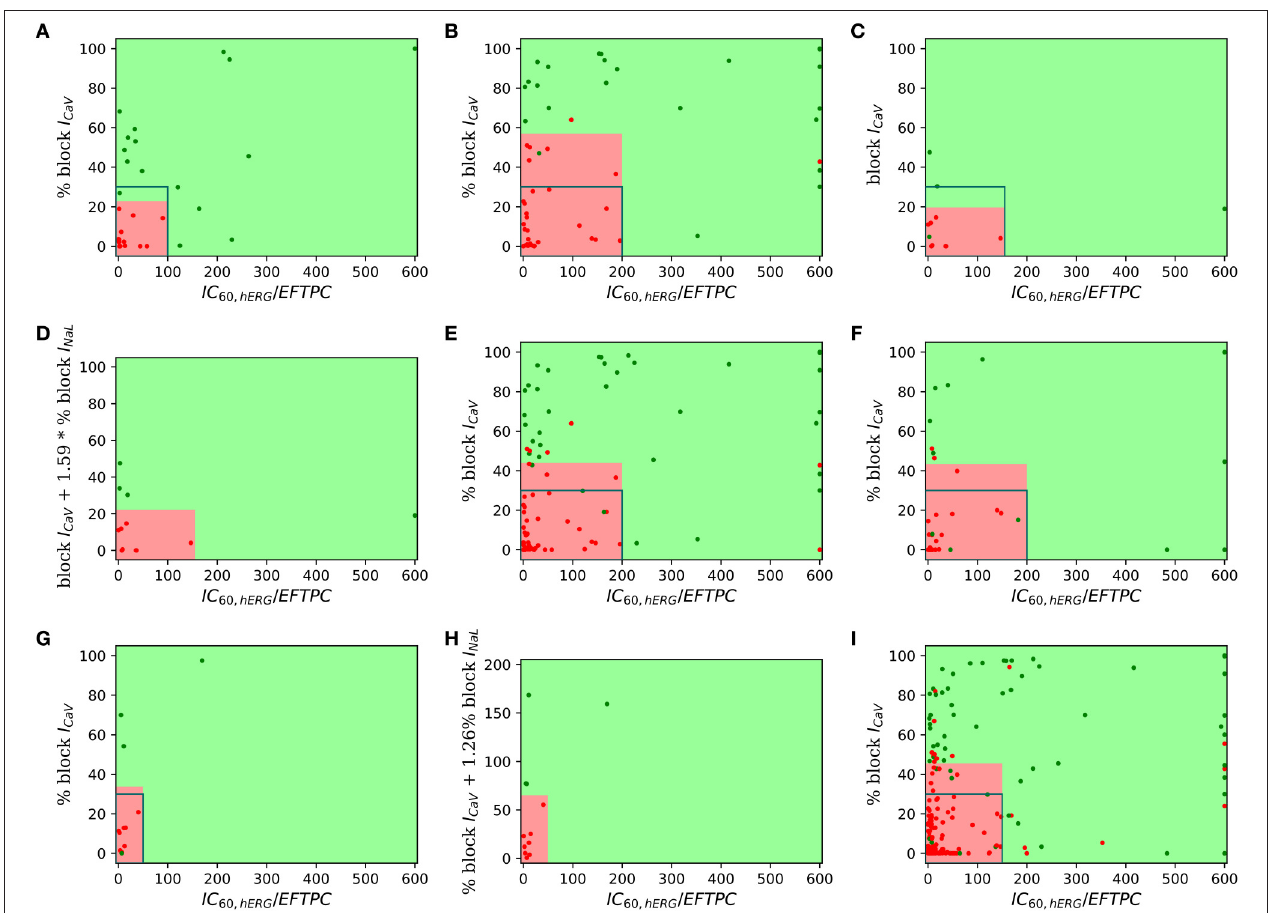
FIGURE 3 | Two-dimensional TdP risk map; blocks of channels are on y-axes and hERG ratio on x-axes for (A) Dataset 1 (Mirams et al., 2011), (B) Dataset 2 (Kramer et al., 2013 ), (C) Dataset 3 (Okada et al., 2015), (D) Dataset 3 ( I Kr , I CaV , I NaL ) (Okada et al., 2015), (E) Dataset 4 (Lancaster and Sobie, 2016), (F) Dataset 6 (Ando et al., 2017), (G) Dataset 7 ( I Kr , I CaV ) (Li et al., 2017), (H) Dataset 7 ( I Kr , I CaV , I NaL ) (Li et al., 2017), and (I) Dataset 8 (merged dataset). The regions in green are low risk regions and the regions in red are high risk areas. Red dots ( • ) indicate TdP + drugs and green dots ( • ) indicate TdP − drugs. For comparsion purposes, we superimpose a blue rectangular outline that shows the separation between EAD + and EAD − regions of parameter space. For binary classification the high and intermediate risk drugs in Dataset 7 were assigned TdP + and the low risk drugs were assigned to TdP −